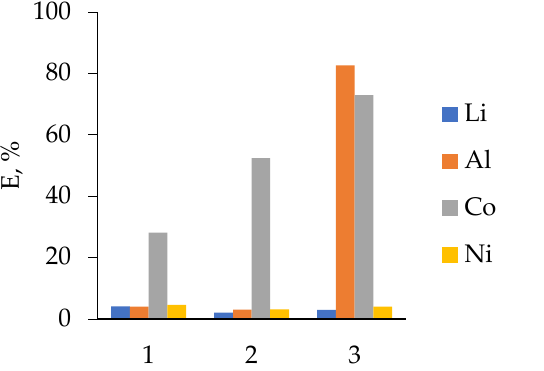
traction with water was carried out for 98.99% in 6 steps.